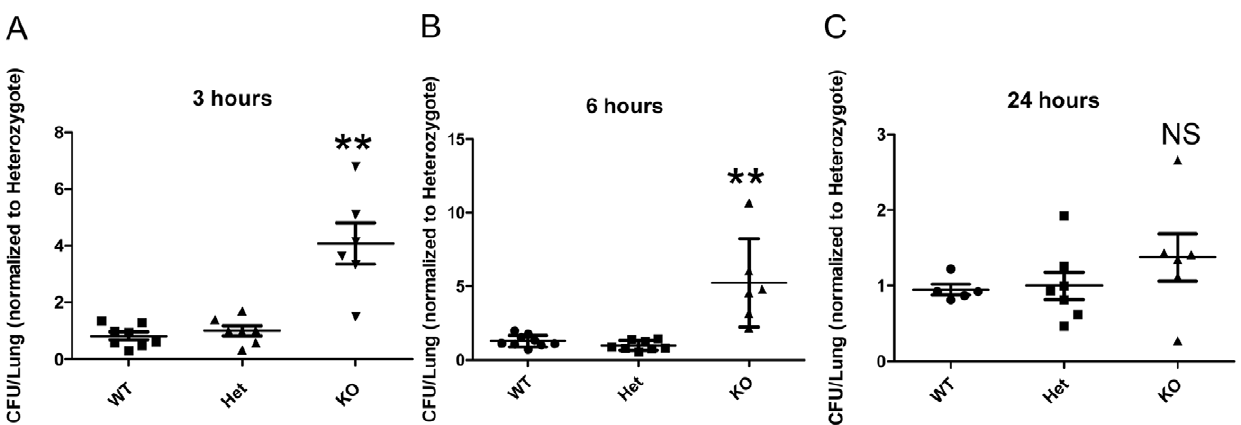
Figure 2. Bacterial load in lungs . Ncr1 + / + (WT), Ncr1 + /gfp (Het) and Ncr1 gfp/gfp (KO) C57BL/6 mice were challenged intranasally with 5 6 10 7 concentration of S. pneumoniae strain WU2. Lungs were harvested for CFU assessment: (A) 3 h after inoculation (n=6 to 8), (B) 6 h (n=5 to 9), and (C) 24 h (n=5 to 6). Results are the summary of 3 independent experiments and were normalized according to the CFU of the Het group that its CFU average was considered as 1 in each experiment. ** p , 0.01, compared with WT or with Het groups 6 SD (two-tailed student t-test). NS, not significant compared with WT or with Het groups. Results are presented as vertical scatter plot of normalized CFU.